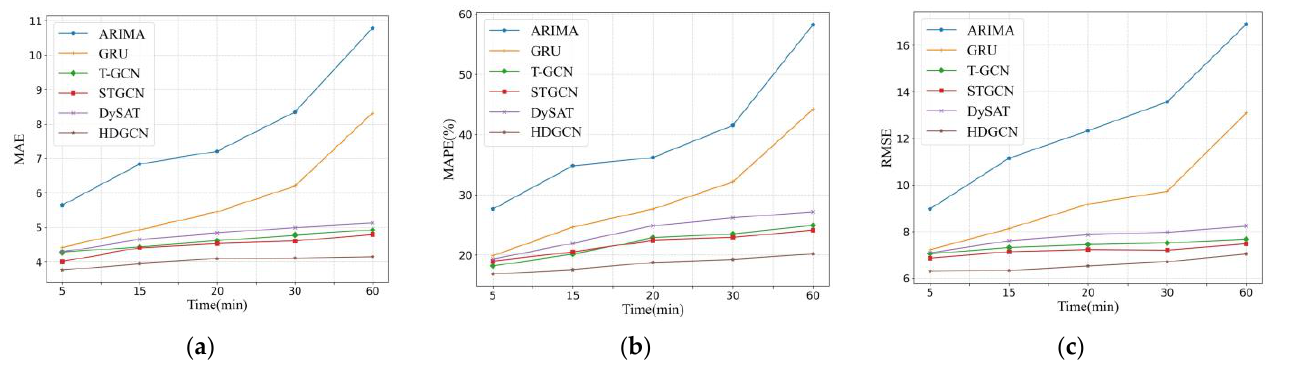
Figure 7. Performance comparison of different model at different length of prediction periods: ( a ) MAE; ( b ) MAPE; ( c ) RMSE.